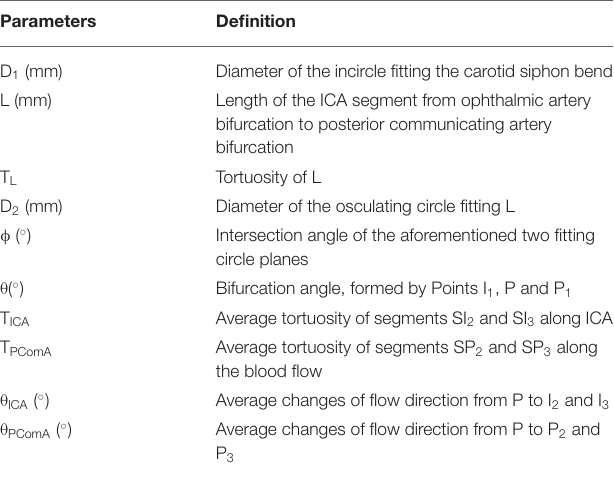
TABLE 1 | Definition of the morphological